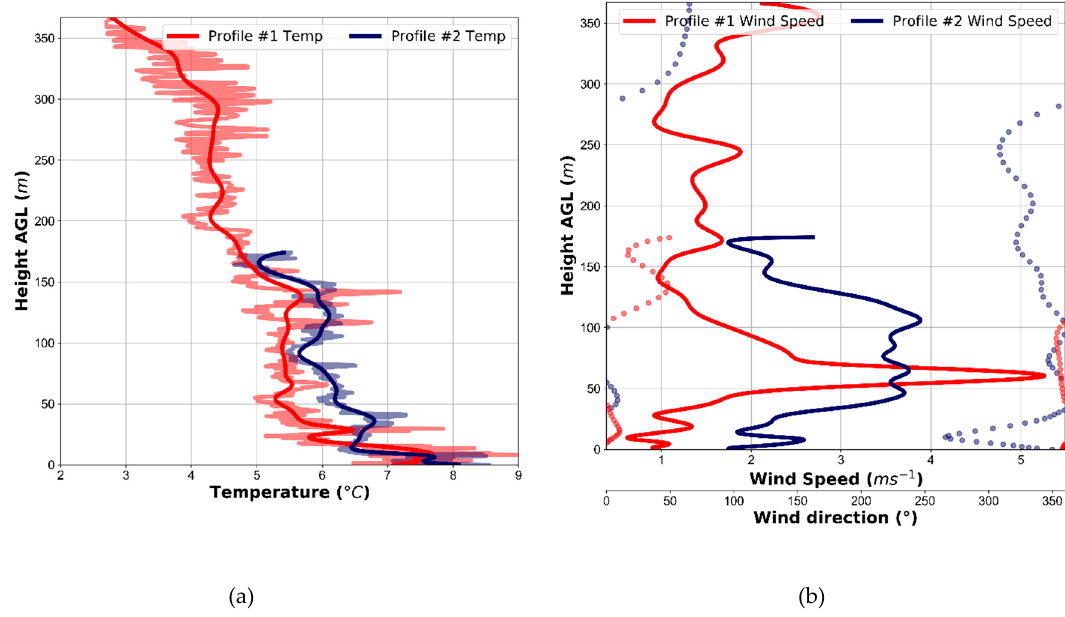
Figure 3. ( a ) Temperature vs. height AGL for profile 1 in red and profile 2 in blue. Bold profiles indicate 15 s moving average with the semi-transparent profiles indicating 1 s moving average. ( b ) Wind speed in solid lines and wind direction in dots for profile 1 in red, and profile 2 in blue.